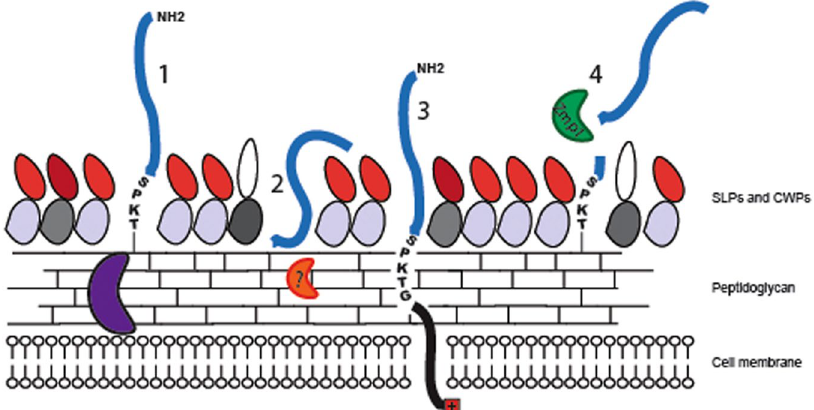
Figure 6. SPKTG sortase substrate processing in C . difficile . A functional model of sortase substrate processing to the cell wall of C . difficile . The surface of C . difficile is comprised of a thick peptidoglycan cell wall (bars), secondary cell wall polymers (not shown) and an external, non-covalently attached S-layer comprised of S-layer protein SlpA (grey and red) and an assortment of minor cell wall proteins (CWPs). Sortase (purple) is shown at the membrane adjacent to a peptidoglycan anchored sortase substrate (1). Through degradation or release by unknown proteases (orange) or non-specific proteolysis, some un-sorted substrates as seen with CD2537 in the absence of sortase are released from the membrane and are non-covalently associated with the cell wall (2). CD3392 remains predominantly anchored in the membrane if sortase is not available to covalently attach it to the cell wall (3). Proteases such as PPEP-1 (green) are able to cleave sortase substrates CD2831 and CD3246 from the cell wall for release into the supernatant